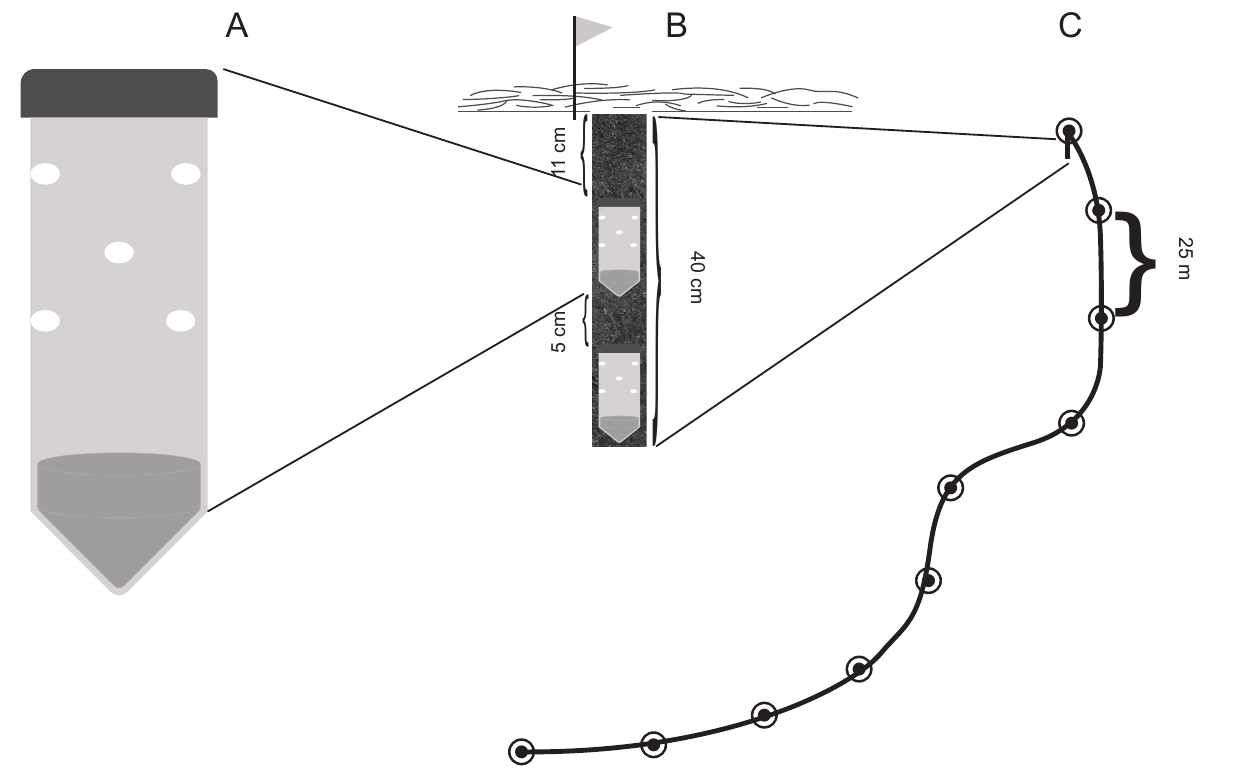
Fig 2 . Representation of the collection trap and sampling unit for underground ants collection. (A) Underground trap with lateral holes; (B) Trap positioning below the surface; (C) Plot with 250 m contour line with 10 sub-sampling units installed at ombrophilous forests in the Brazilian